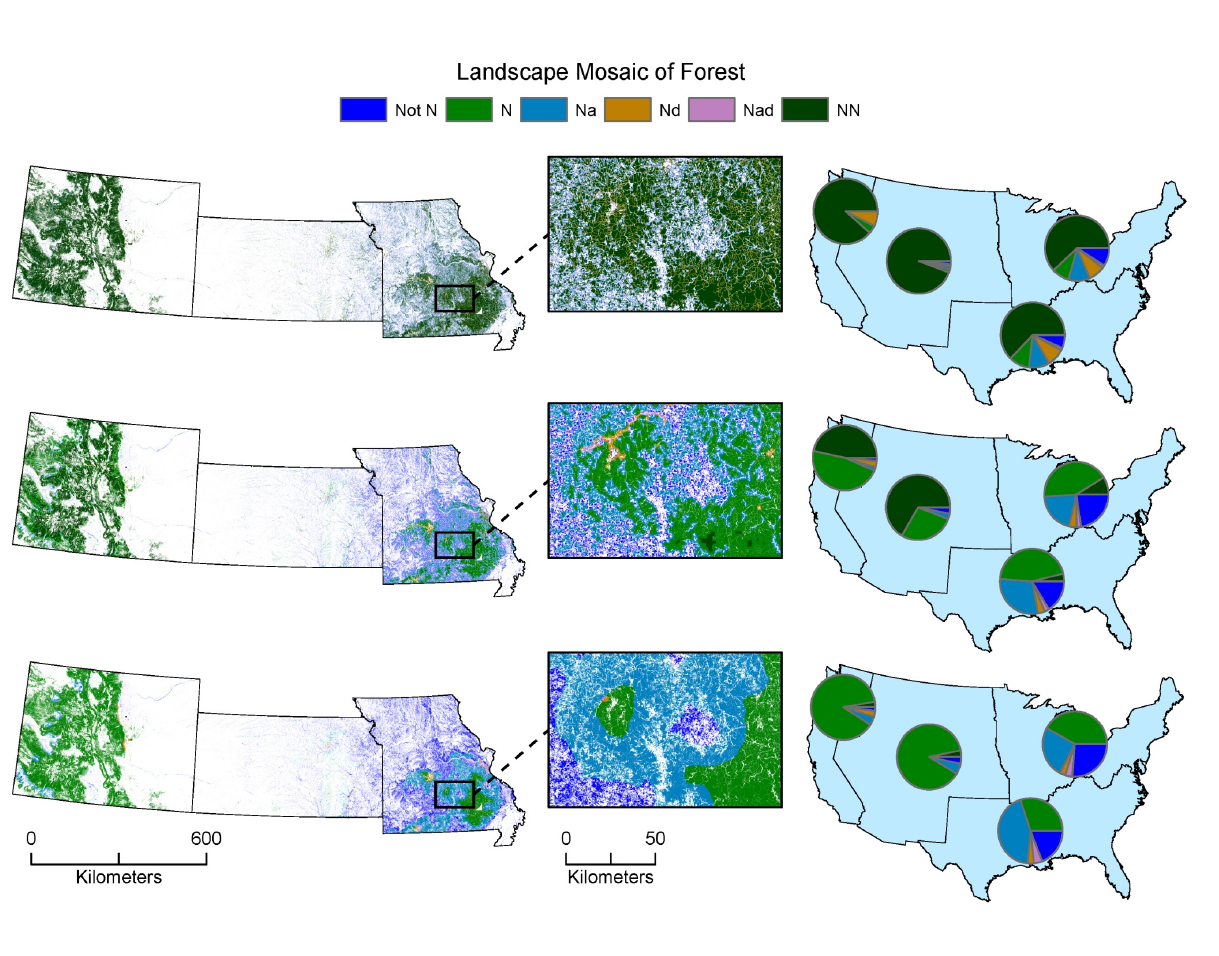
Figure 4: The landscape mosaic of forest, in landscapes that are dominated by natural land-cover. Left: Forest distribution is indicated by the colored pixels, and the color of a pixel indicates its landscape mosaic context in landscapes of size 4.4 ha (top), 591 ha (middle), and 47800 ha (bottom). Center: Illustrations of spatial detail near the Ozark Plateau. Right: The relative proportions of forest area in anthropogenic interface zones in each of four regions are shown by the pie charts. Note: „Not N“ refers to landscape backgrounds not dominated by natural land-cover types. of all grassland and forest exists in 4.4-ha